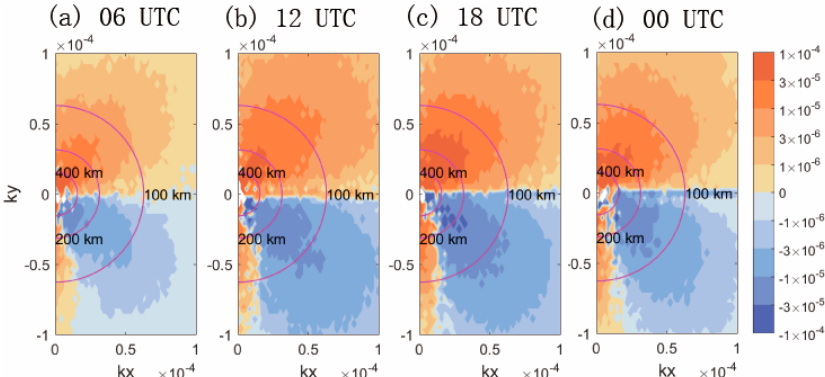
Figure 7. Time − averaged meridional momentum flux power spectra at 30 hPa in horizontal (kx, ky) wavenumber space for 12-h forecast results at ( a ) 06 UTC, ( b ) 12 UTC, ( c ) 18 UTC and ( d ) 00 UTC.